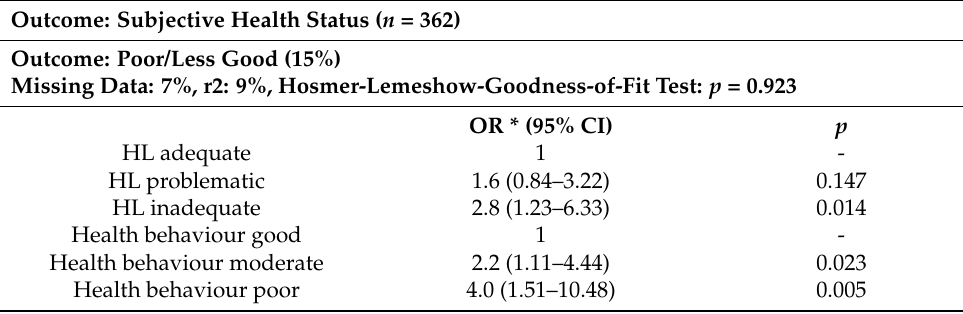
Table 6. Multivariate logistic regression: subjective health status.